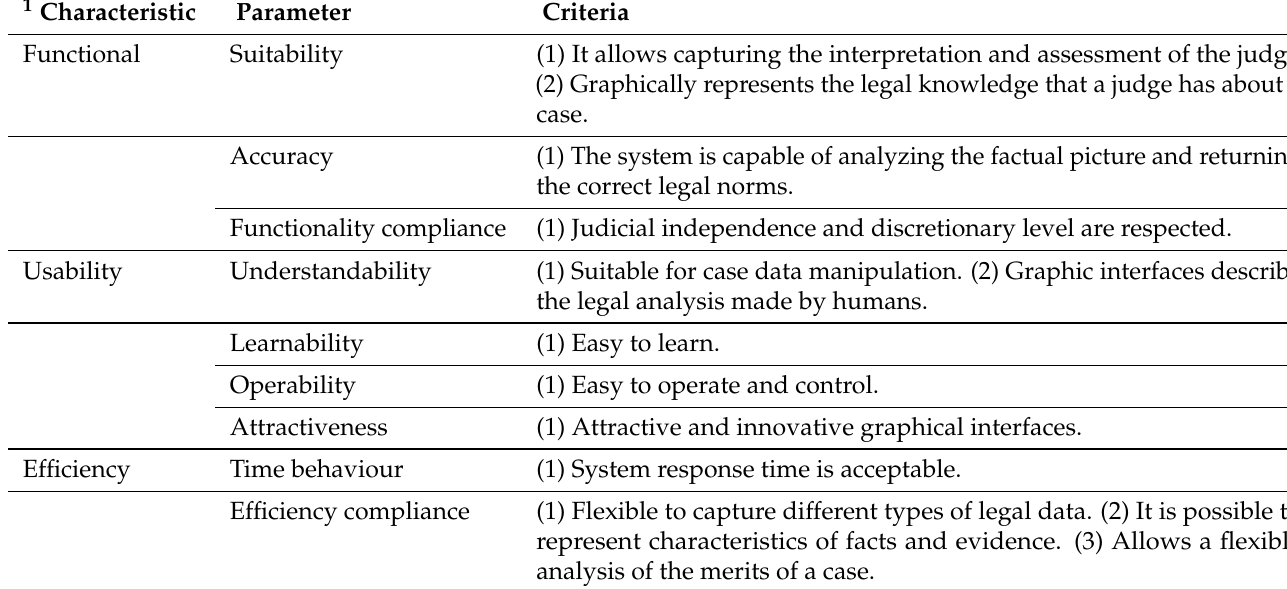
Table 2. Software evaluation characteristics defined in ISO-25010 [97] to study the behavioral response of the judge. 1